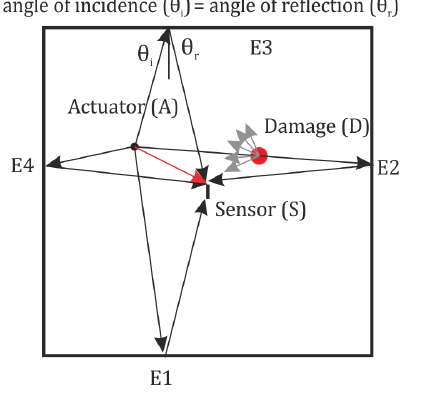
Figure 2. Concept of edge reflection-based ray